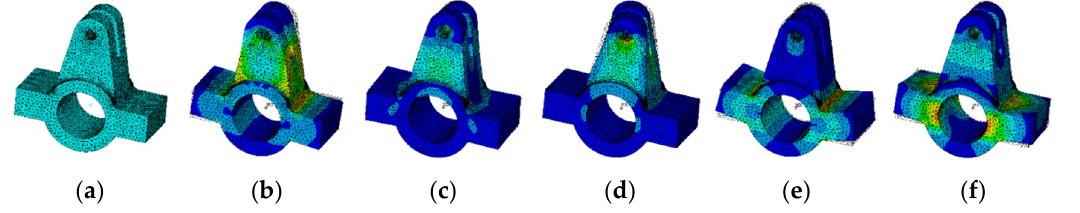
Figure 15. Finite element model of flexible lever arm and modal diagrams of the first five modes: ( a ) finite element model; ( b – f ) first to fifth modes. Table 6. The eigenfrequencies of three flexible parts (Unit: Hz). Parts